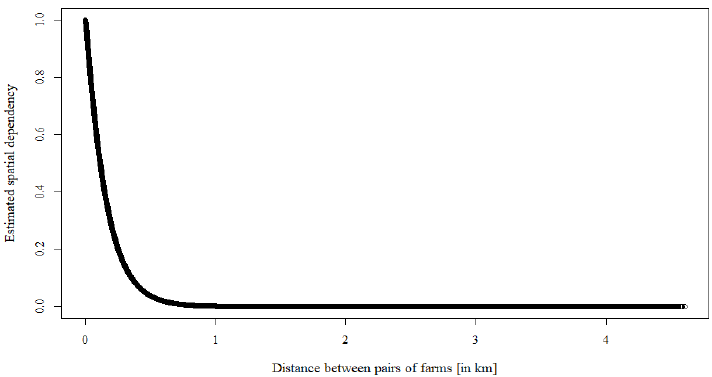
Figure 1. Spatially correlated random effects. As estimated from Equation (4) with respect to the distance between pairs of farms (km).